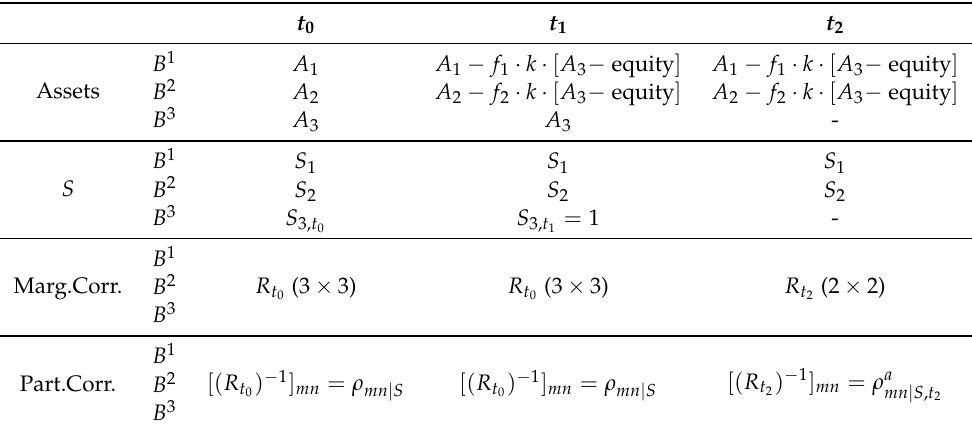
Table 1. Variables’ time-evolution,